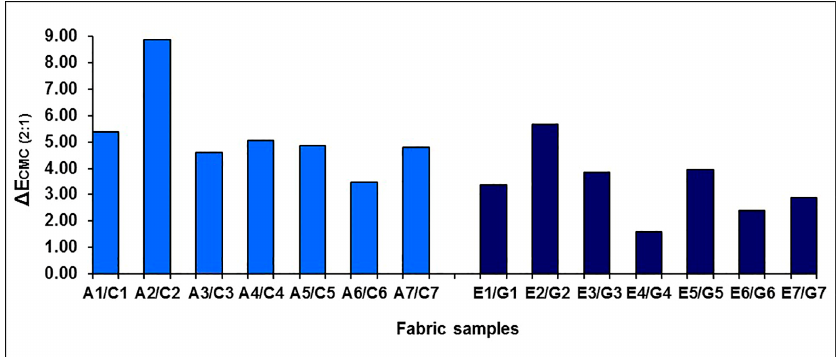
Figure 9. The color differences between blue-red and yellow-green mixed fabrics, without and with regulating layers.